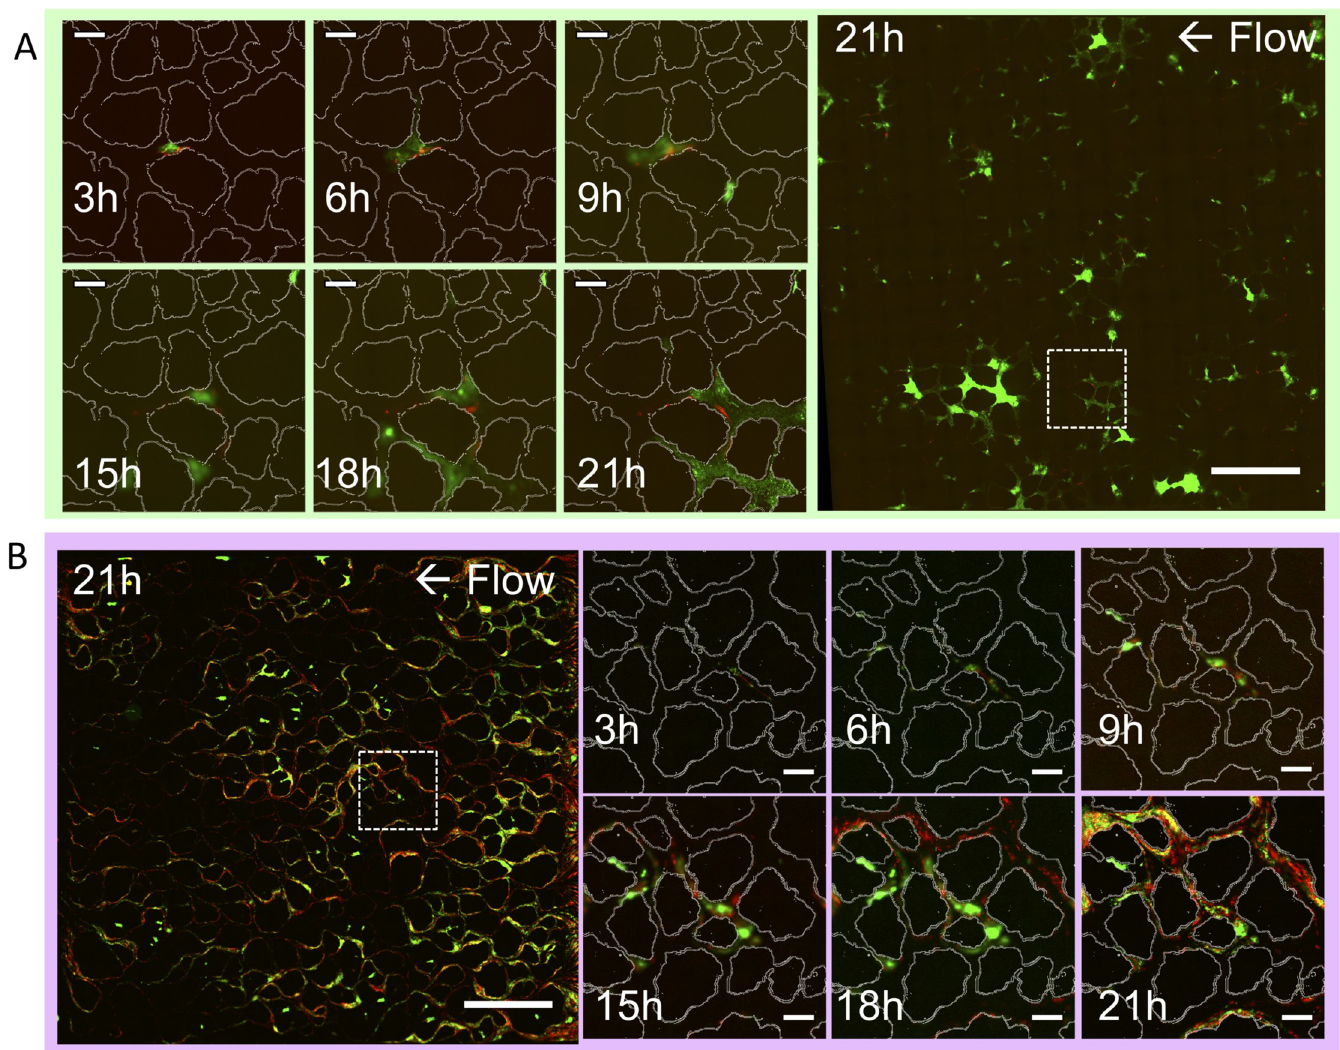
Fig 3. Representative fluorescent images show Pantoea cells growing within the pore space over time. A) WT and B) Δ UDP demonstrate different spatial distribution of living (green) and dead (red) cells across platform after 21 hours (scale bars = 1mm). Images from a subset (indicated by dashed box) of the device show biofilm growth within a pore over time with the grain design overlaid (white) (scale bars = 100 μ m).